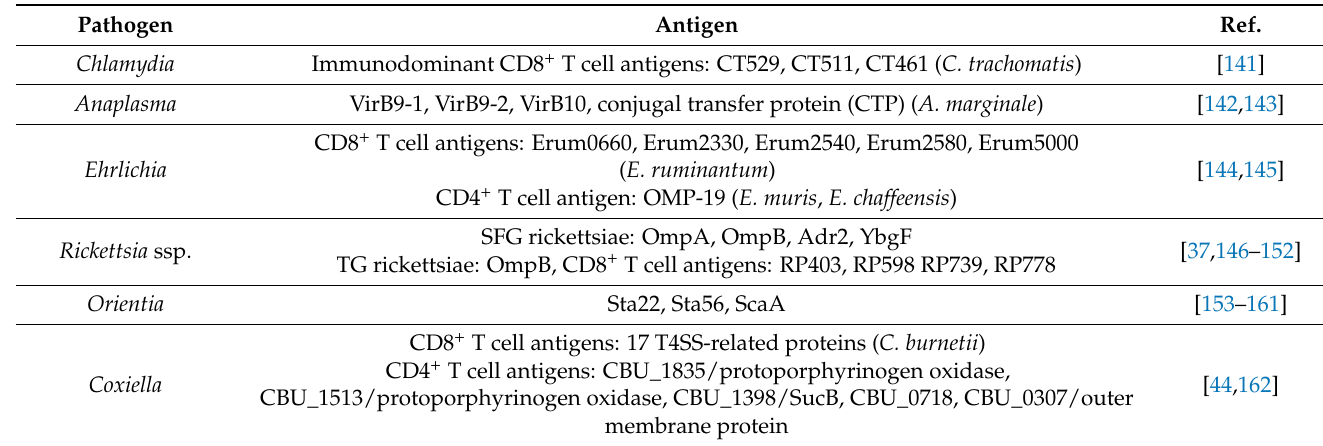
Table 2. A selection of T cell antigens from obligate intracellular bacteria that have been described in the